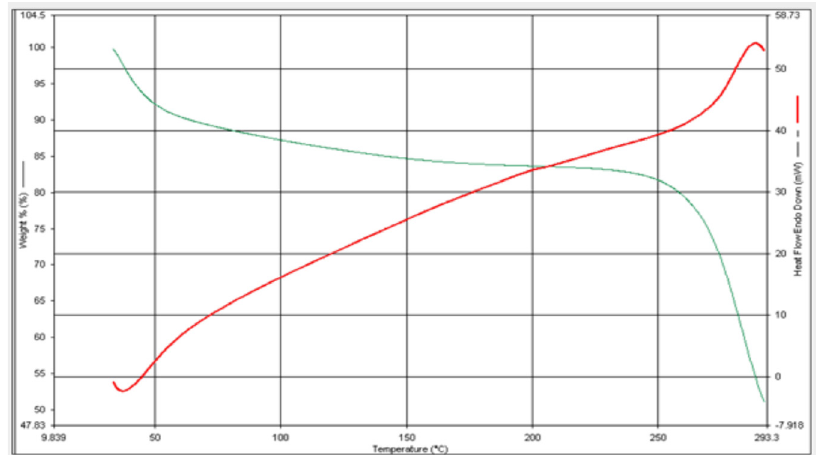
FIGURE 8 (c) - Differential scanning calorimetric analysis of sodium carboxymethyl